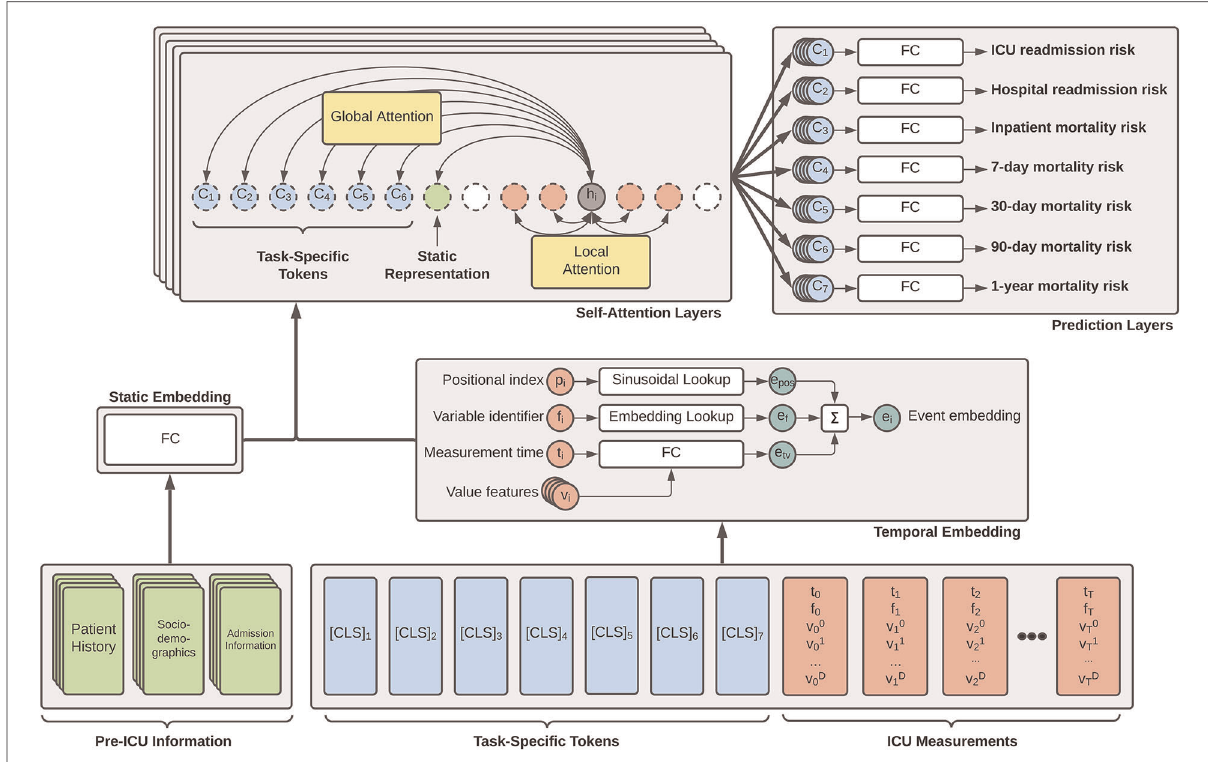
FIGURE 1 Overview of our proposed generalized EHR Longformer network for simultaneously predicting multiple patient outcomes in the ICU. Pre-ICU information includes summarized history of patient medications and laboratory tests, sociodemographic indicators, and features relating to hospital admission. Temporal ICU measurements take the fl exible form of tuples: ( p , non-unique positional index of clinical event based on timestamp; t , elapsed time from ICU admission, f , unique measurement identi fi er integer; ~ v , set of continuous features derived from measured values). Task-speci fi c [CLS] tokens are assigned t = time of prediction and ~ v ¼ 0. Tokens are individually embedded and passed through a stack of Longformer layers with sliding self-attention windows. Global attention is applied to static feature representation and prediction tokens.